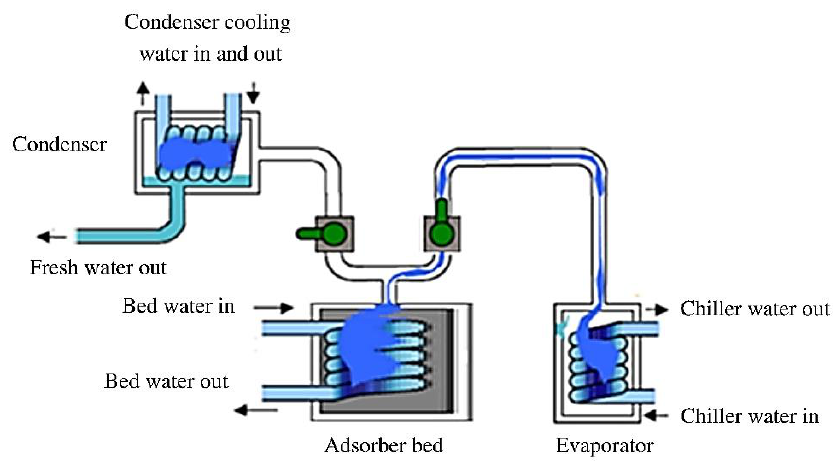
Figure 2. Schematic diagram for one-bed adsorption desalination. Reproduced with permission from [20]. Elsevier, 2017.